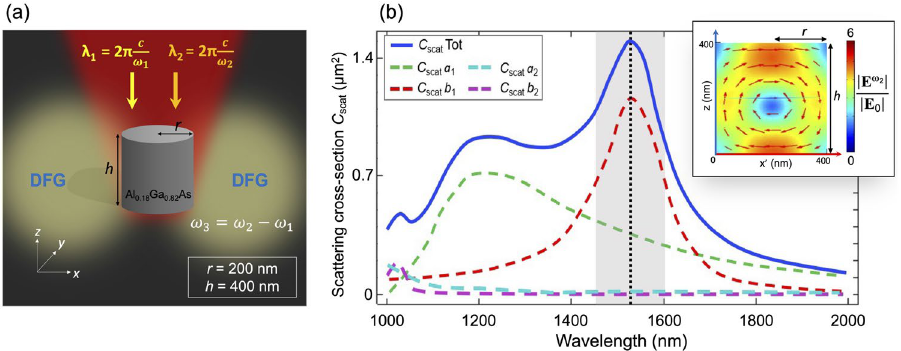
Figure 2. ( a ) The proposed AlGaAs nanodisk has radius r = 200 nm, and height h = 400 nm. Two plane waves in the near-infrared region, (cid:31) 1 and (cid:31) 2 , are normally incident and generate through the bulk χ ( 2 ) the nonlinear DFG signal. The schematic representation elucidates the THz generation by optical rectification of intra-pulse components of the incident infrared laser pump. ( b ) Scattering cross section decomposed in the multipolar contributions: electric ( a 1 ), magnetic ( b 1 ) dipole and electric ( a 2 ), magnetic ( b 2 ) quadrupole components, respectively. The gray area indicates the wavelength of the input beams. The inset shows the electric field enhancement inside the nanodisk at the MD resonance (black dotted line), in a plane (zx ′ ) forming 45 ◦ with respect to the x and y axes. The red arrows highlight the circulating electric field. The plot is obtained by using COMSOL Multiphysics v5.5—https:// www. comsol.